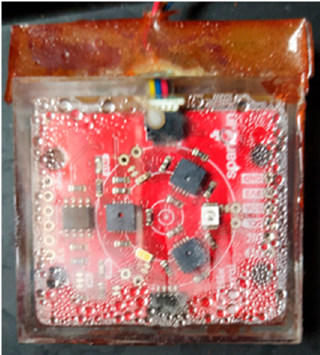
Figure 13. Leaking sensor box, two days after the completion of the